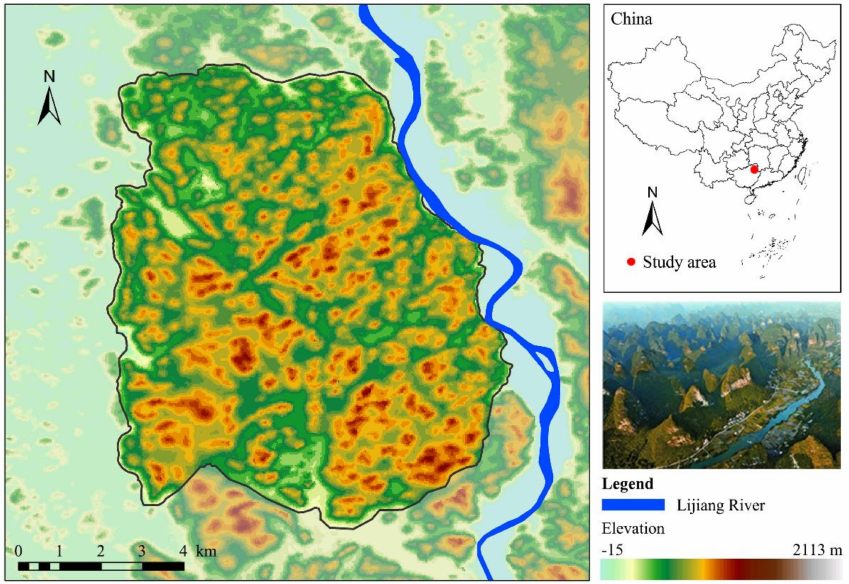
Figure 2. Study area in Lijiang River in Guilin, Guangxi Province,